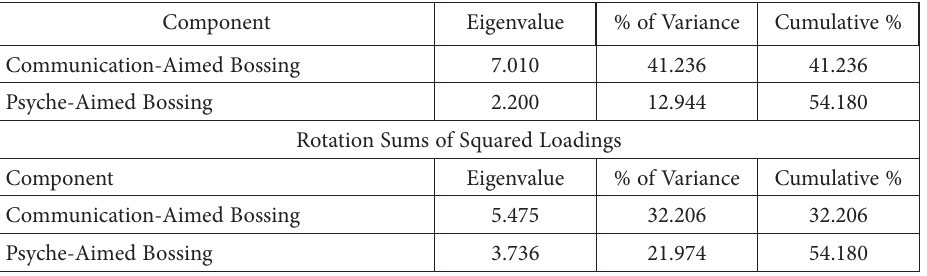
Table 1b. Basic parameters of the BOSS factor